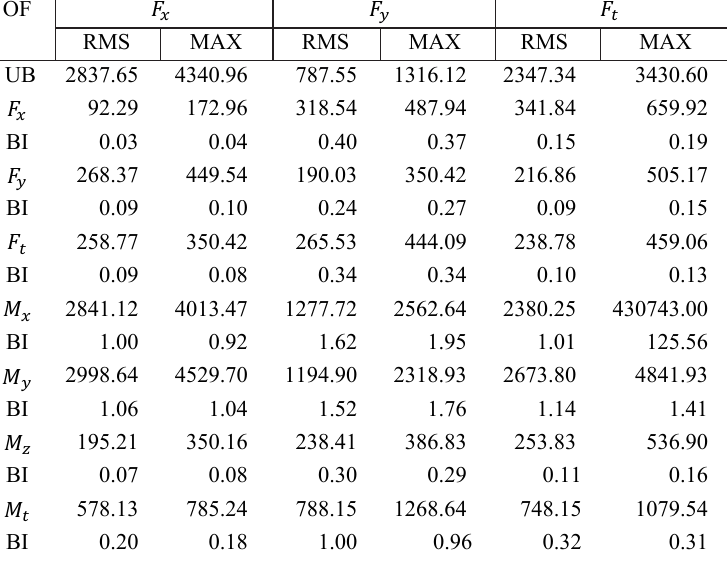
Table 1. RMS, MAX and BI results of shaking force components